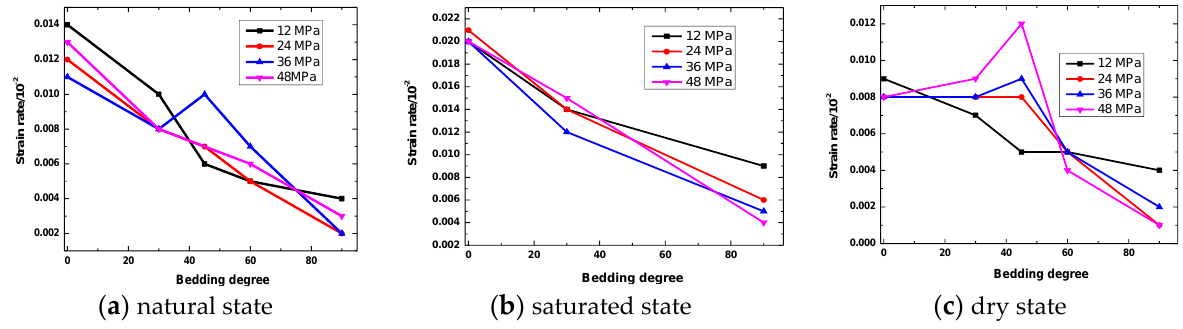
Figure 17. Creep strain with bedding angle of rock sample under different